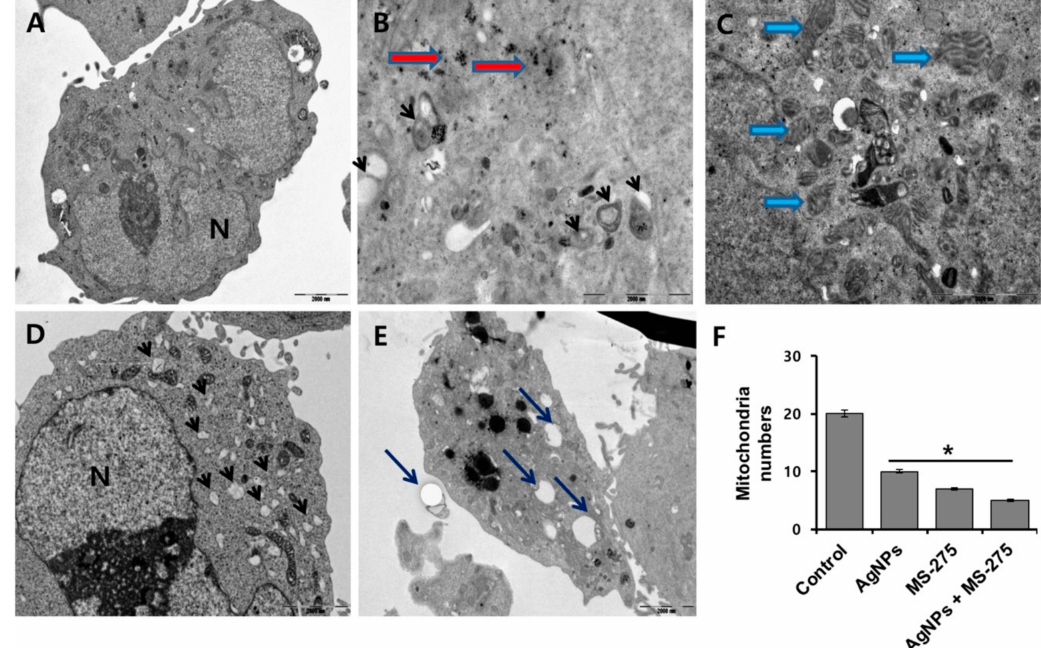
Figure 7. AgNPs and MS-275 induced accumulation of autophagosomes. A549 cells were incubated with AgNPs (1 µ M), MS-275 (1 µ M), or a combination of AgNPs (1 µ M) and MS-275 (1 µ M) for 24 and hand-processed for TEM. ( A ) The control cells showed clear nuclear morphology without any defects in organelles. ( B ) AgNPs treated cells depicting AgNPs enter into the cells and cause accumulation of autophagosomes (thick short arrow). ( C ) MS-275-treated cells showed accumulation of autophagosomes, swollen mitochondria, and many multi-vesicular and membrane-rich autophagosomes. ( D ) AgNPs and MS-275-treated cells showed accumulation of a significant number of autophagosomes. ( E ) Mitochondria copy number was determined by real-time PCR. ( F ) Results are expressed as mean ± standard deviation of three independent experiments. There was a significant difference in treated cells compared to untreated cells with Student’s t -test (* p <